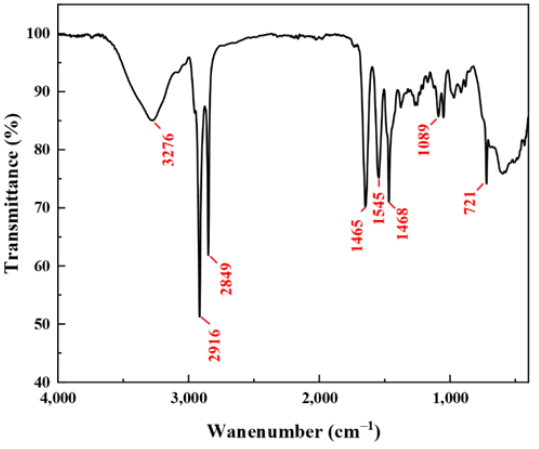
Figure 3. FTIR spectrum of